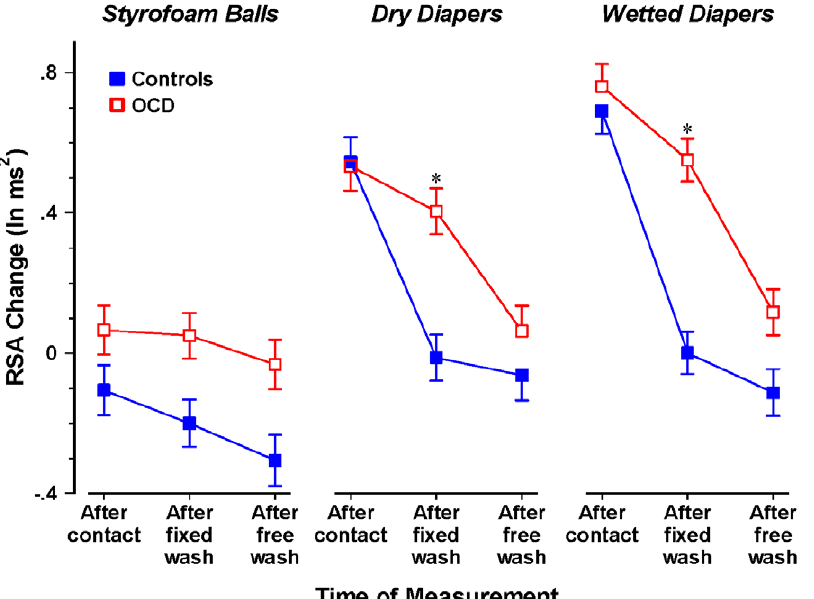
Figure 1. Effect of stimulus contact and subsequent hand washing on RSA in OCD patients with washing compulsions vs. non- patient controls. To index activation of the security motivation system, RSA change was computed as baseline RSA minus RSA level; thus, increases in the index correspond to greater activation Fixed wash was limited to 30 s; free wash was as long as the participant wanted. Note: * p , .05 vs. controls at the same time of measurement. Error bars represent 1 SE.